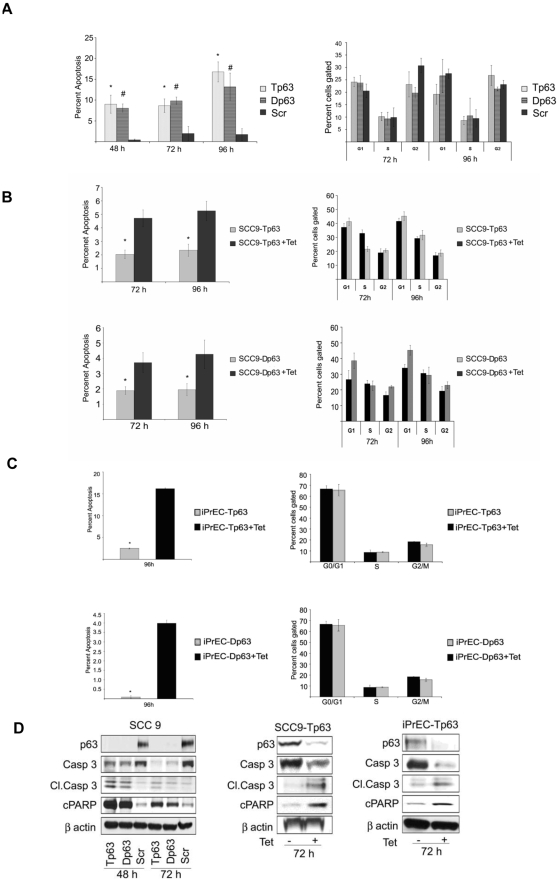
Silencing of either Total or ΔN specific p63 isoforms induces apoptosis with no significant changes in cell proliferation.A–C. Flow cyometric analysis of SCC9 cells transfected with Tp63, Dp63 or Scr siRNAs (A), SCC9-Tp63 and SCC9-Dp63 cells with or without treatment tetracycline (B) and iPrEC-Tp63 and iPrEC-Dp63 cells with or without treatment tetracycline (C). Left panels show quantification (percentage) of the sub G1 population measured by PI staining. Right panels show the fractions of cells in the various phases of the cell cycle, as determined by BrdU incorporation. Data are shown as means +/− standard error and are representative of three independent experiments. D. Immunoblot analysis of apoptosis-related proteins in SCC9 cells transfected with Tp63, Dp63 or Scr siRNAs (left panel), in SCC9-Tp63 cells with or without treatment with tetracycline (middle panel) and in iPrEC-Tp63 cells with or without treatment with tetracycline (right panel).